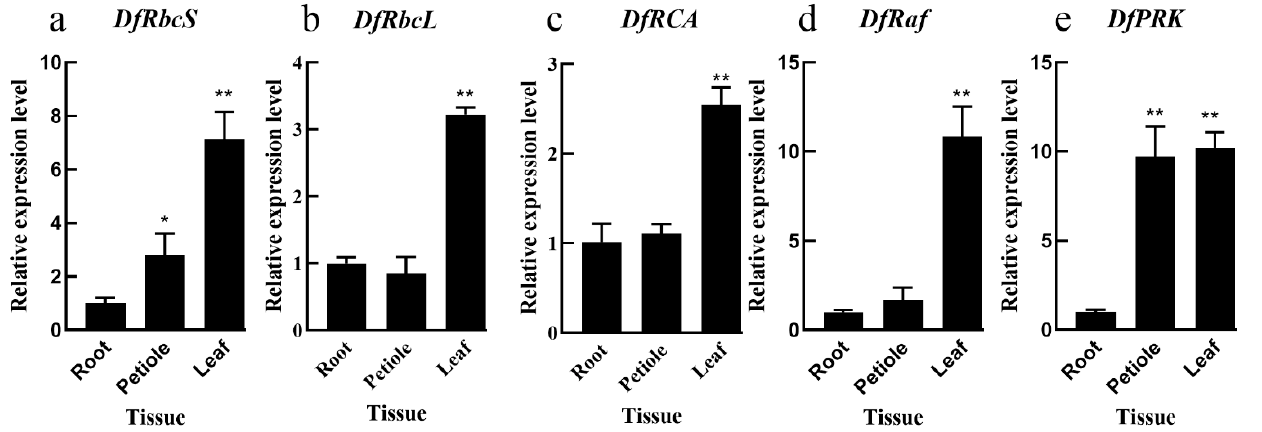
Figure 1. The relative expression levels of DfRbcS ( a ), DfRbcL ( b ), DfRCA ( c ), DfRaf ( d ) and DfPRK ( e ) in different fragrant woodfern tissues. Each bar corresponds to the mean value ± SD of three independent replicates. * p < 0.05; ** p < 0.01.